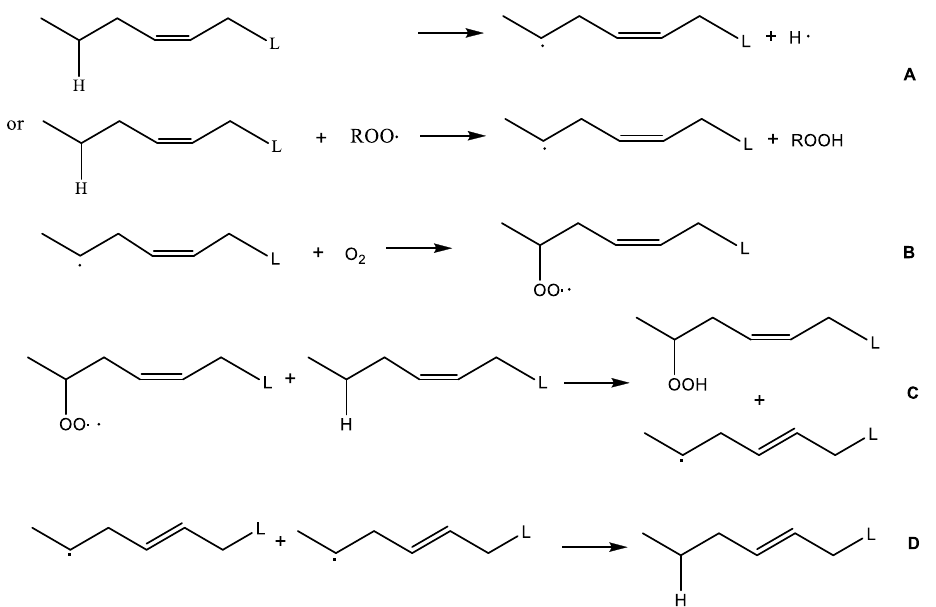
Figure 1. The main lipid peroxidation reactions. Hydrogen is abstracted from an olefinic acid (LH) molecule to form alkyl radicals (L . ), usually in the presence of a catalyst, such as metal ions, light, heat, or irradiation, at a relatively slow rate; alternatively, free peroxide radicals (ROO . ) capture a hydrogen atom from the allylic methylene group conjugated to a double bond in the unsaturated fatty acid chain (LH) with consequent formation of a radical on the carbon atom correspondent (L . ) ( A ), induction. Next, radicals L . react very quickly with molecular oxygen, generating peroxyl radicals LOO . ( B ) that subtract a hydrogen atom to another molecule of the unsaturated fatty acid to form a hydroperoxide and a free radical L . ( C ). The L . produced react with each other and give rise to products not radicals-inactive ( D ), the termination phase.